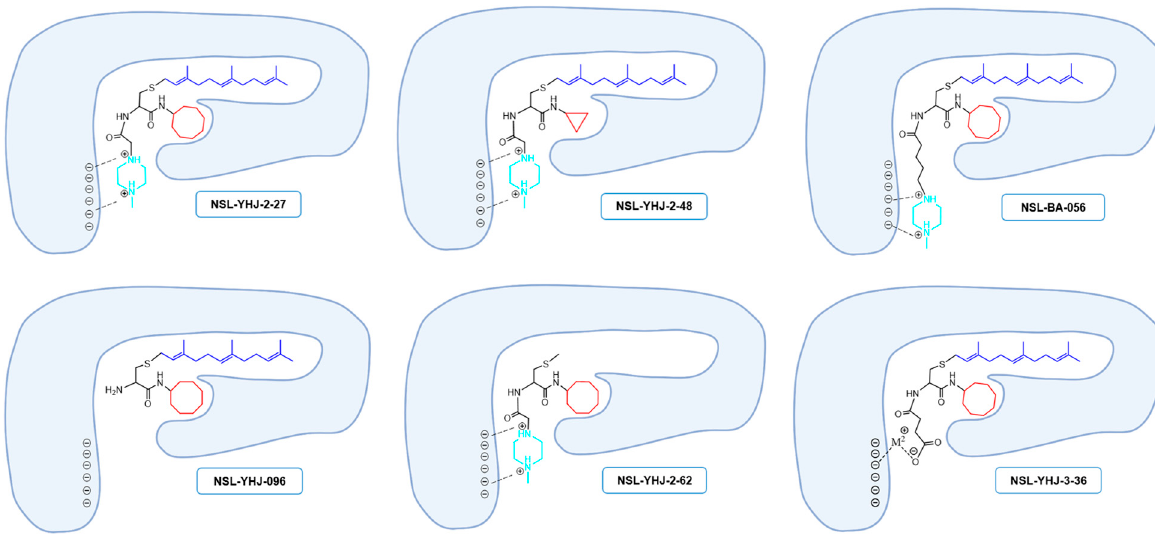
Figure 7. Structure–activity-relationship-based depiction of possible PCAIs interactions with potential targets. Schematic diagrams showing the possible ionic and hydrophobic interactions of the analogs with the target are based on the relative effects of the analogs against cancer cell viabilities. The most potent analogs (NSL-YHJ-2-27 and NSL-BS-056) are believed to have the most cooperative binding contacts for higher affinities and potencies. Although other factors such as the degree of cell entry may be in play, the surprising effectiveness of NSL-YHJ-3-36 suggests possible contribution of salt bridge to its effectiveness.